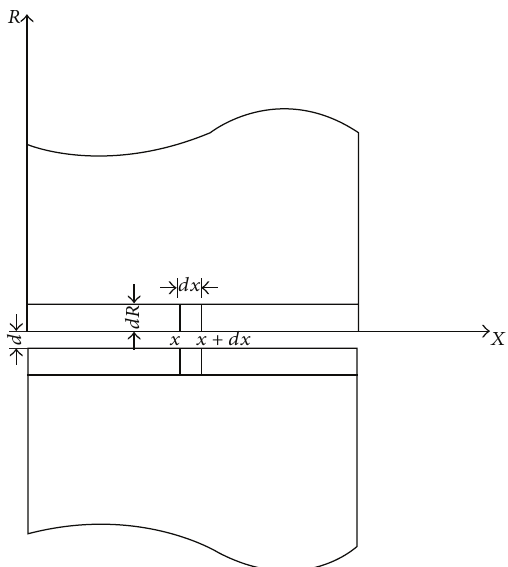
Figure 5: Sketch for dynamic dissolution of rock salt.